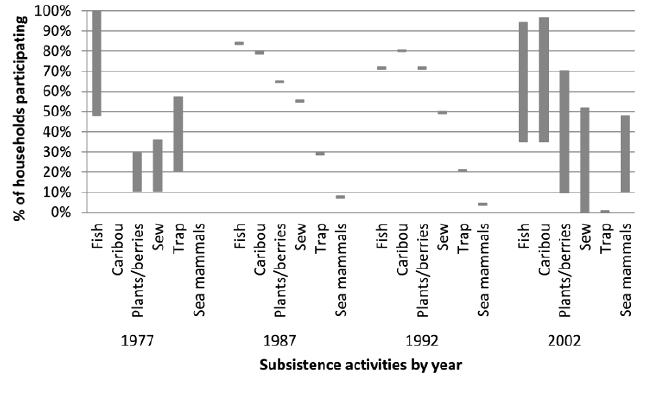
Fig. 3. Percentage of adults participating in subsistence activities. Bars indicate the range of the estimates. Source: North Slope Borough census 1978, 1988, and 1993 ( unpublished data ), Survey of living conditions in the Arctic 2003 ( unpublished data ).